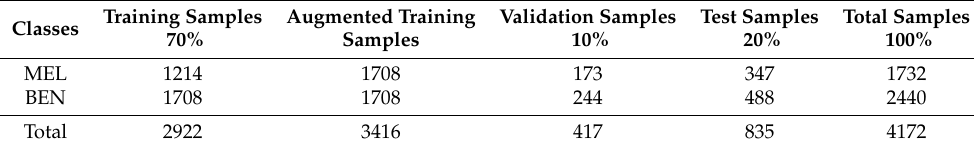
Table 2. The ISIC 2017 data distribution among training, validation, and test sets.